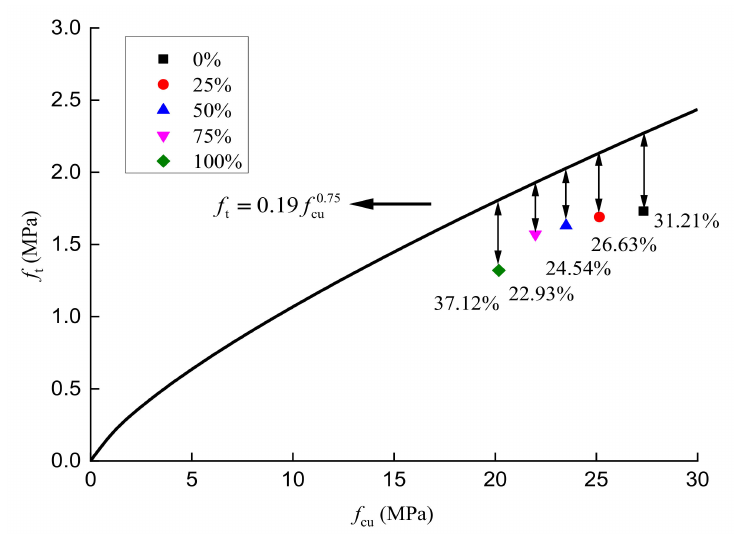
Figure 7. Correlation between the peak compressive stress and peak tensile stress of